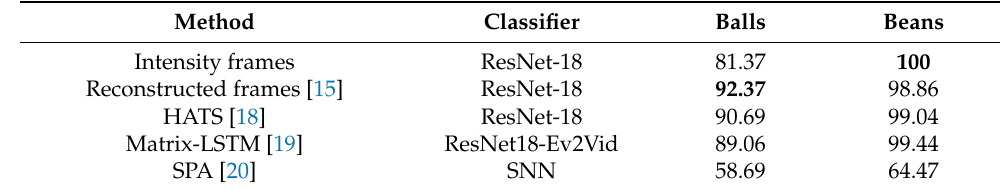
Table 2. Classification accuracy in percent of the presented datasets using contrast-based windowing and state-of-the-art classification